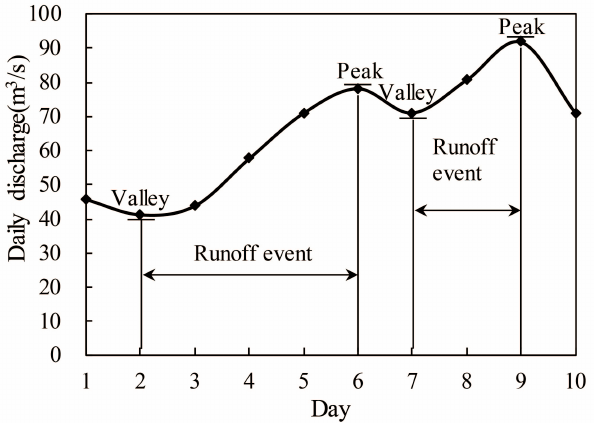
Figure 2. Definition of runoff event. Table 1. Runoff indices based on the definition of runoff event in this study.